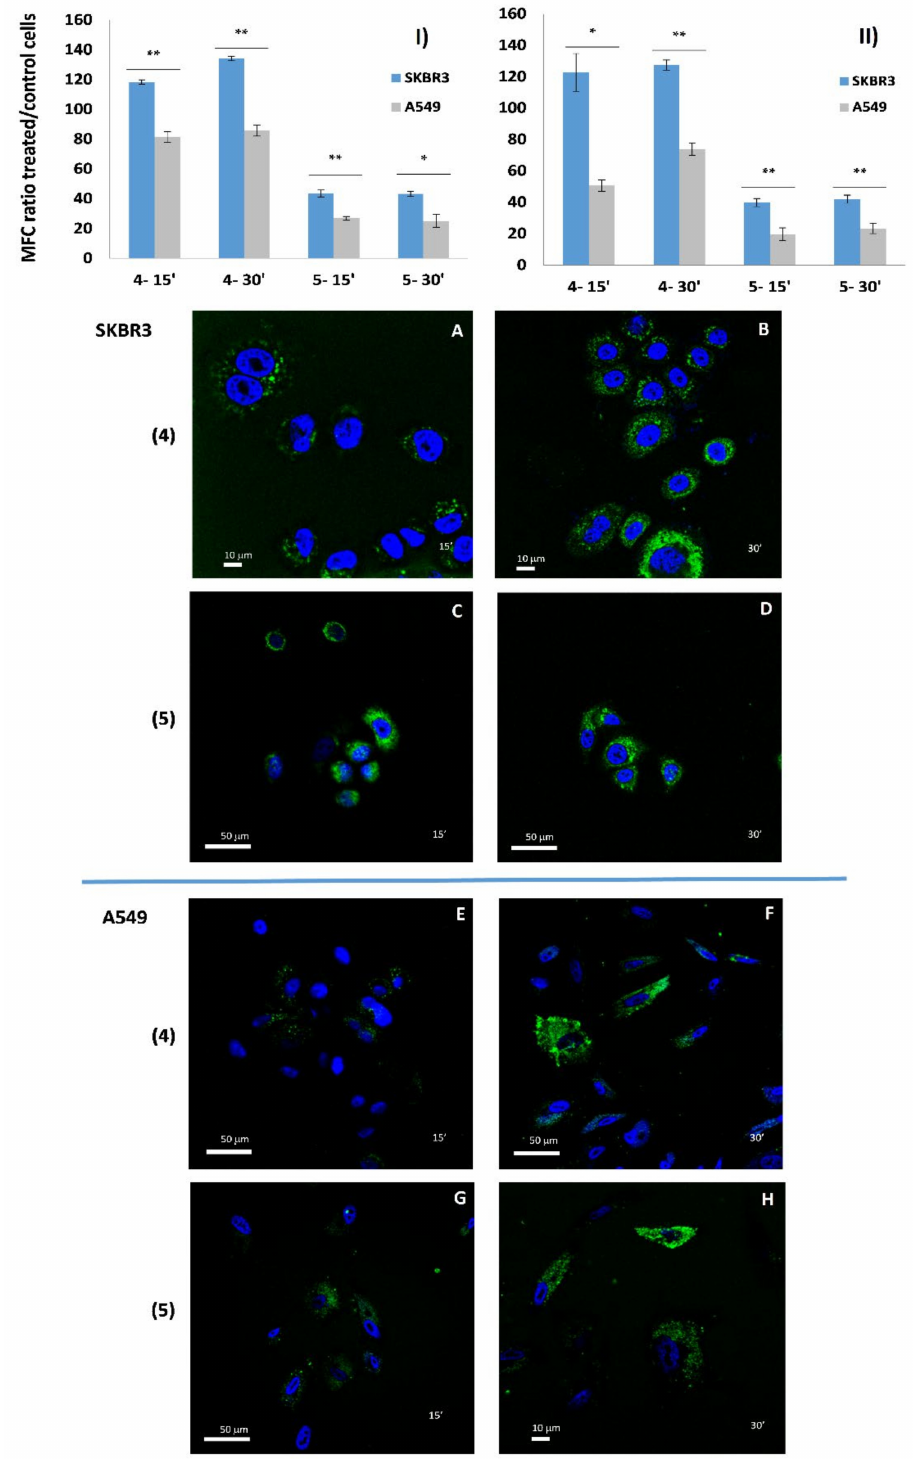
Figure 2. Top: Flow cytometry analysis of uptake of 5 µ M compounds ( 4 ) and ( 5 ) in SKBR3 and A549 cells at 4 ◦ C (panel I ) and at 37 ◦ C (panel II ). Data are expressed as mean ± standard deviation from two independent experiments. Asterisk indicates a significant difference in the uptake values between the two cell lines ( t -test, * p < 0.05, ** p < 0.01). Bottom: real time cell culture conditions confocal images of uptake of compounds ( 4 ) and ( 5 ) (cid:48) at 37 ◦ C. H33342 was used for nuclei staining. Green fluorescence refers to FITC. Uptake in SKBR3 cells at 15 (cid:48) (panels A and C ) and 30’ (panels B and D ). Uptake in A549 cells at 15’ (panels E and G ) and at 30’ (panels F and H